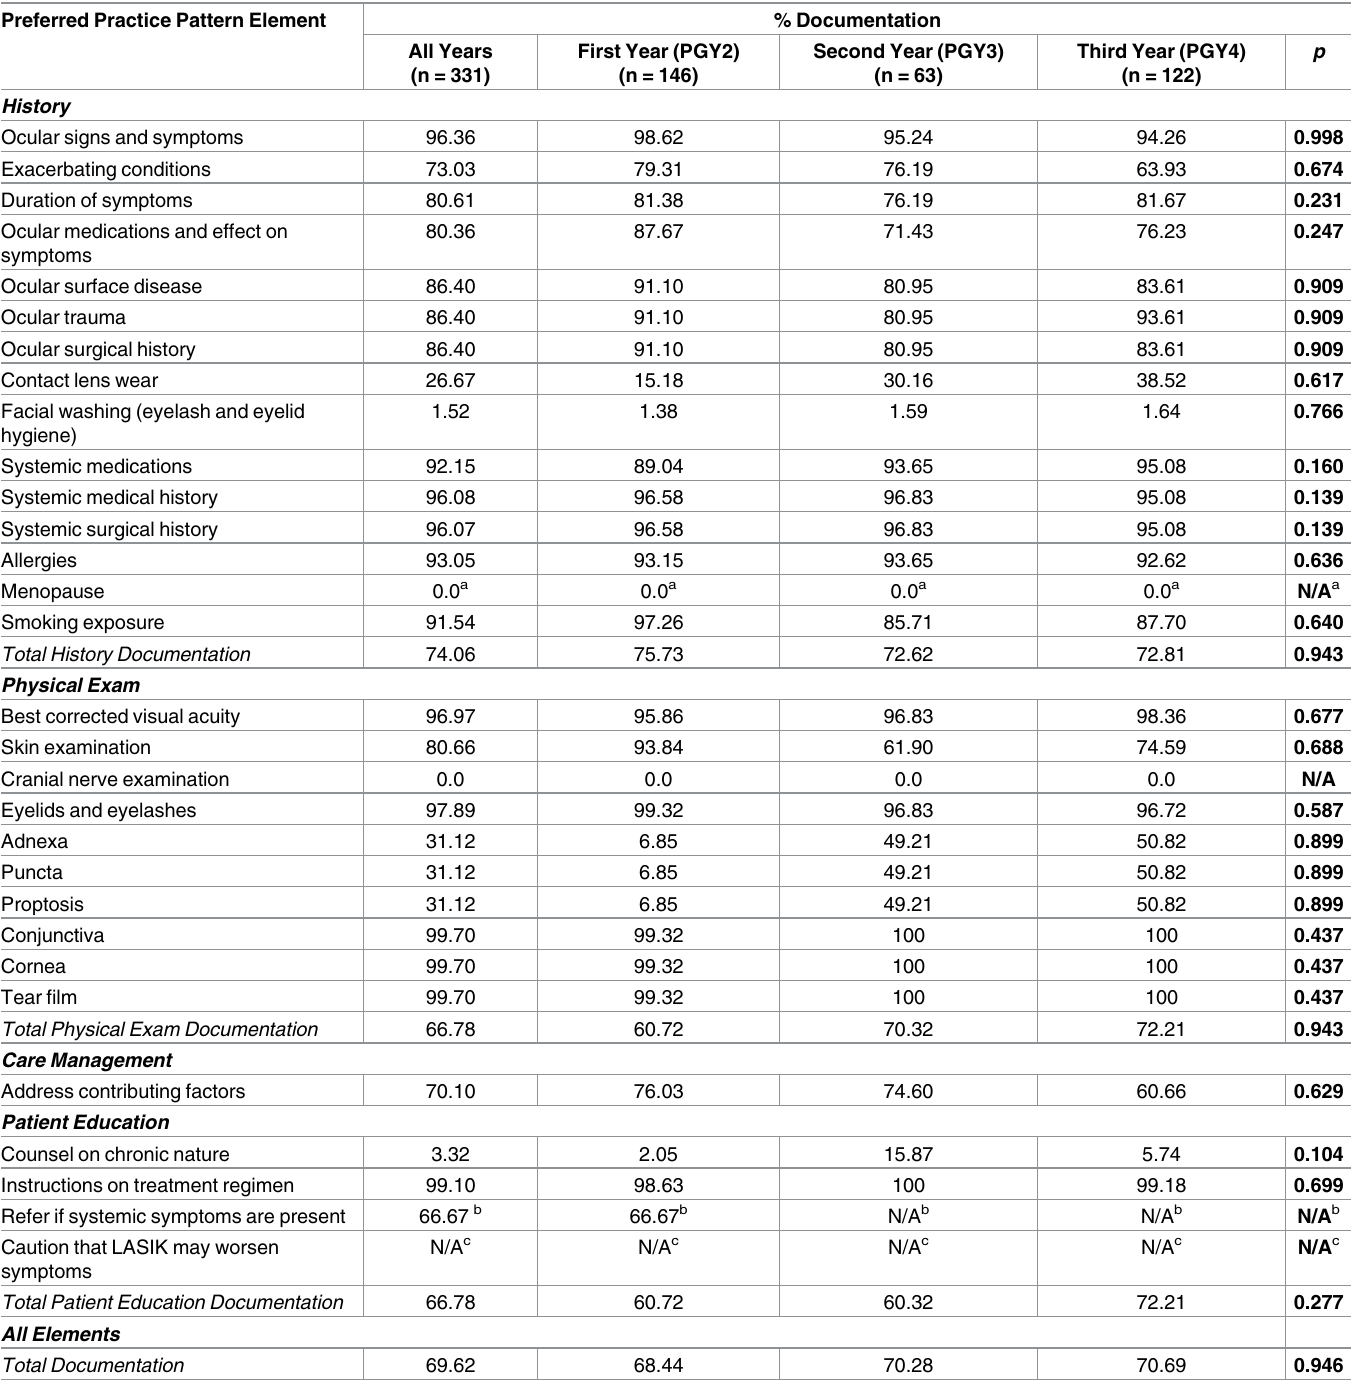
Table 2. Overall averagedocumentation by resident year. Preferred Practice Pattern